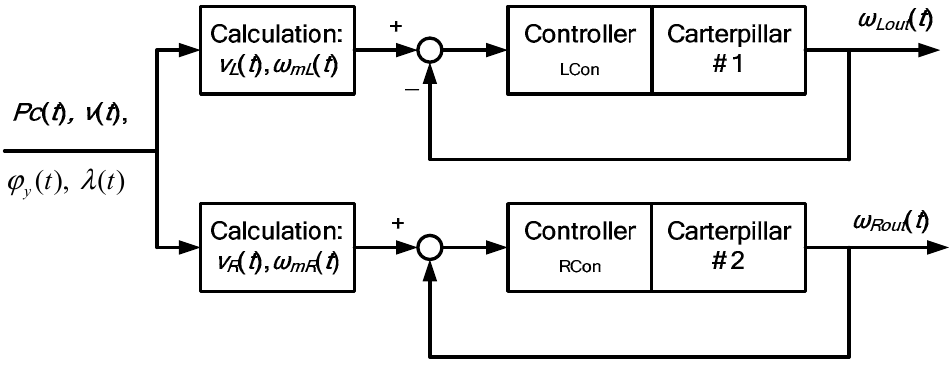
Figure 11. Speed control block diagram for caterpillars .